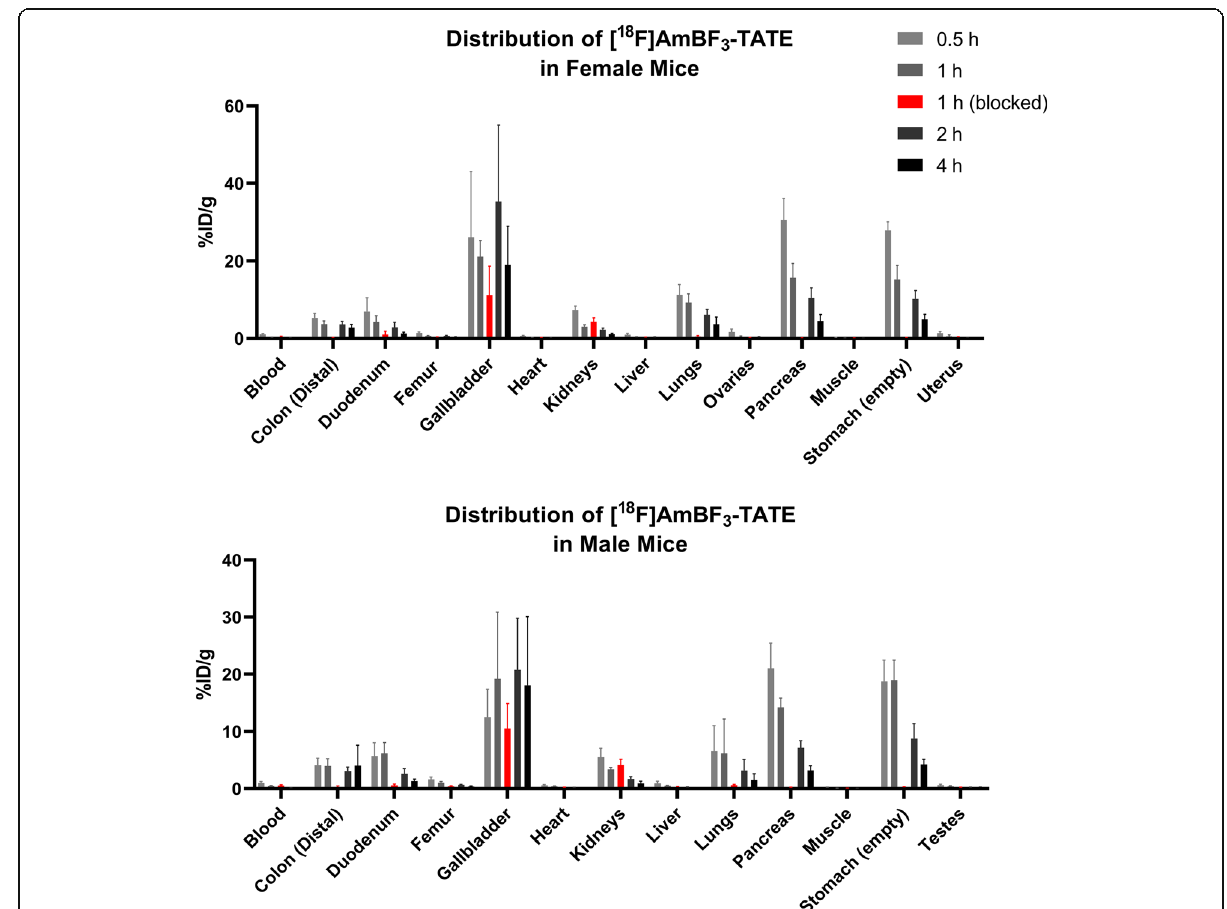
Fig. 3 Distribution of [ 18 F]AmBF 3 -TATE in mice at selected time points. Blocking was performed with pre-injection of 100 μ g of [ 19 F]AmBF 3 -TATE 30 min before radiopharmaceutical